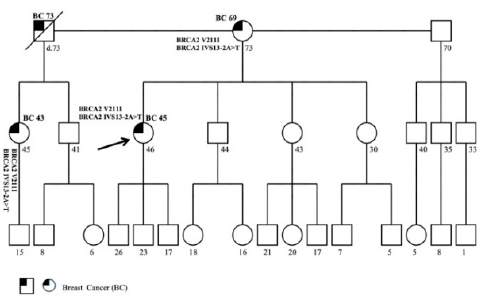
Figure 3. Pedigree of family 3 carrying the DM in BRCA2 c.631G > A (p.Val211Ile) and c.7008-2A > T (IVS13-2A > T). The ages at diagnosis are indicated in brackets.